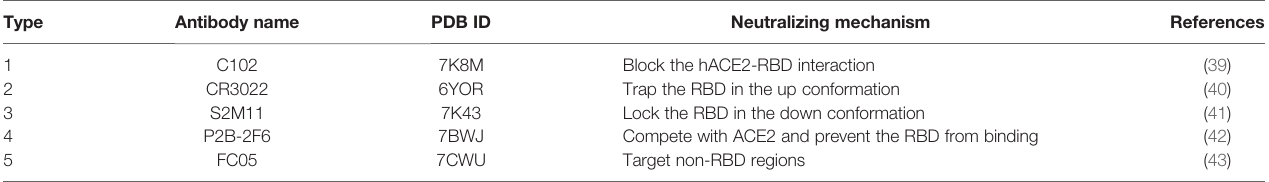
TABLE 3 | Five types of antibodies neutralizing by SARS-Cov-2.